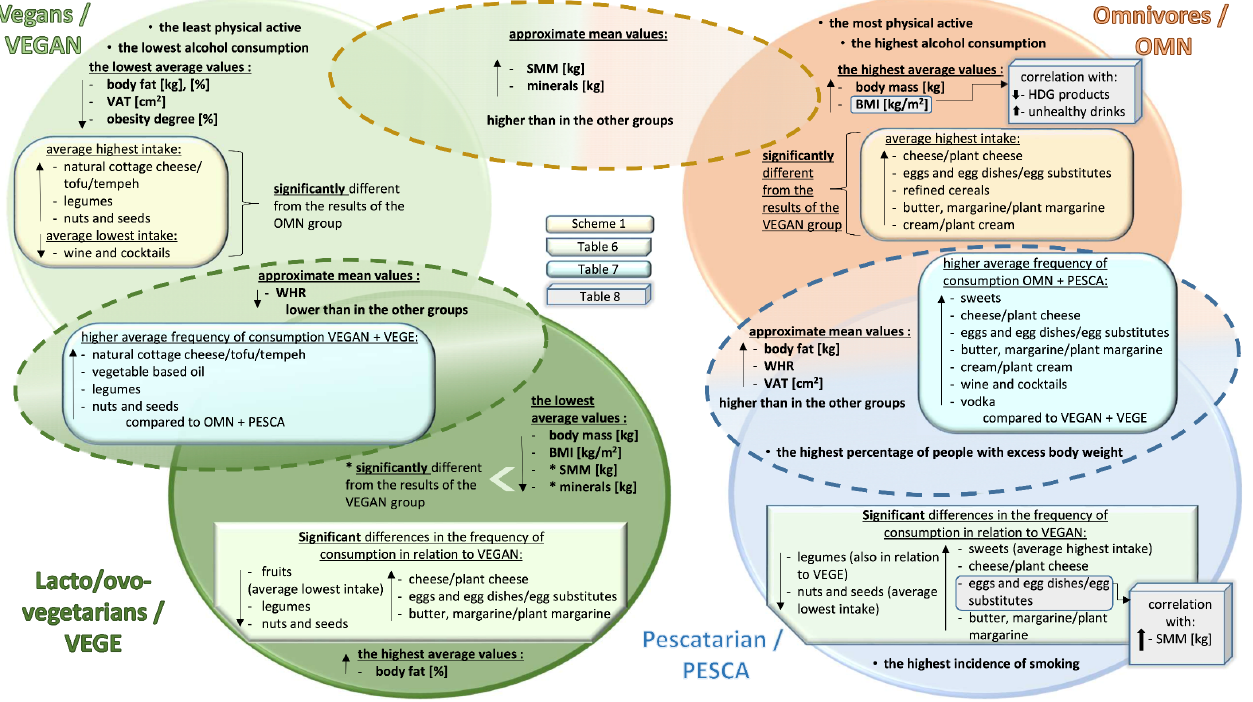
Scheme 2. Summary of results of the study groups.